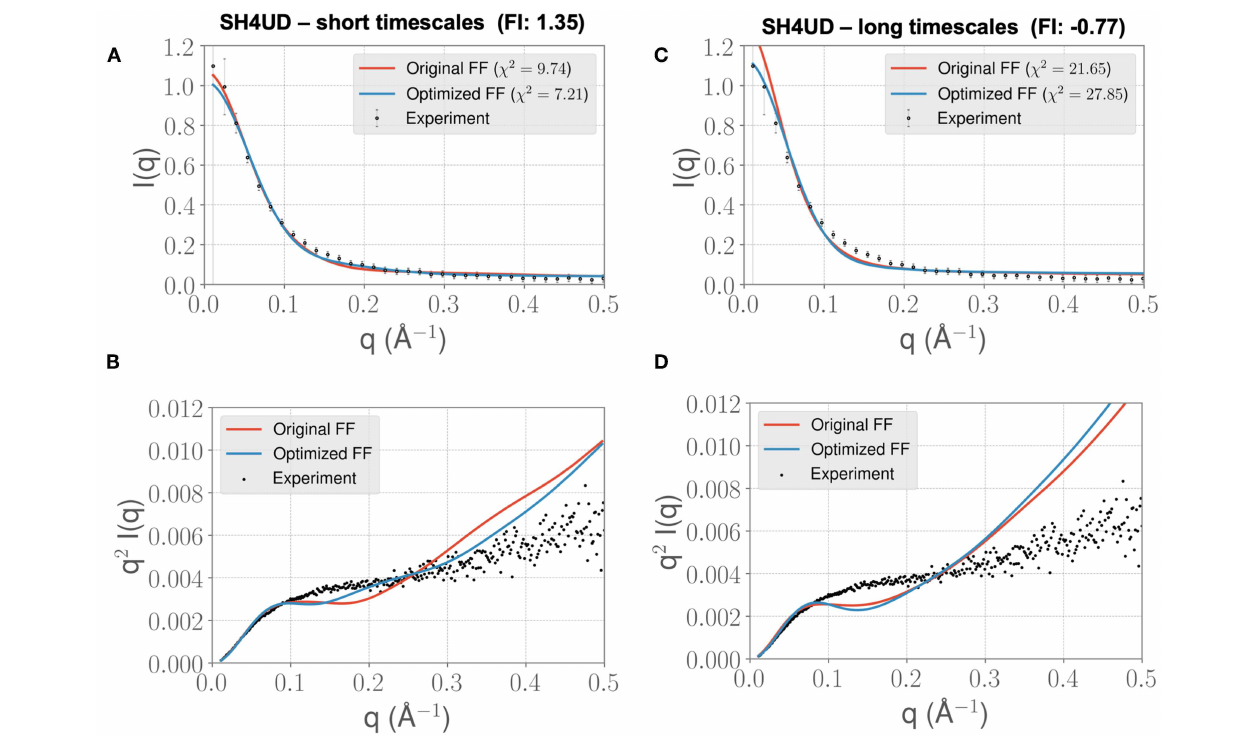
FIGURE 7 | FF parameters learned from the PaaA2 simulations used to simulate the SH4UD IDR improves the fit to experimental SAXS data. Although the factor of improvement (FI) is lower than the other two systems (A) , the fit to the experimental data as seen from the Kratky plot (B) shows better agreement in the mid- q range. This allows us to determine that the parameters learned from one simulation can be used reasonably on other proteins as well. Further fine-tuning may be essential to obtain better fits (especially with solvent-protein interactions). (C) and (D) highlight the same information as in (A) and (B) but for longer timescales. Note that the factor of improvement has